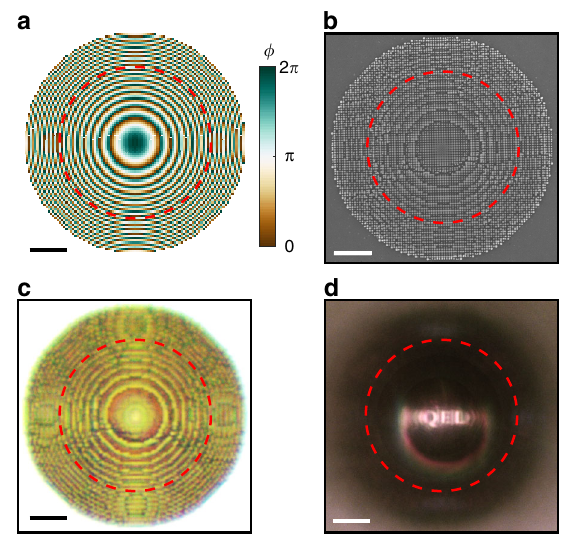
Fig. 2 Metalens design and fabrication. Top – down images of: a the discretized Fresnel phase pro fi le used for the design; b SEM image of the fabricated structure, c bright- fi eld re fl ection optical image of the metalens surface; d image of a macroscopic chromium shadow mask with the Quantum Engineering Lab logo, 〈 Q|E|L 〉 , formed through the metalens in a bright- fi eld transmission microscope. Red, dashed lines indicate the effective aperture of the metalens. All scale bars denote 5 μ m. Re fl ected light from the planar diamond surface surrounding the metalens in c saturated the camera, making it appear